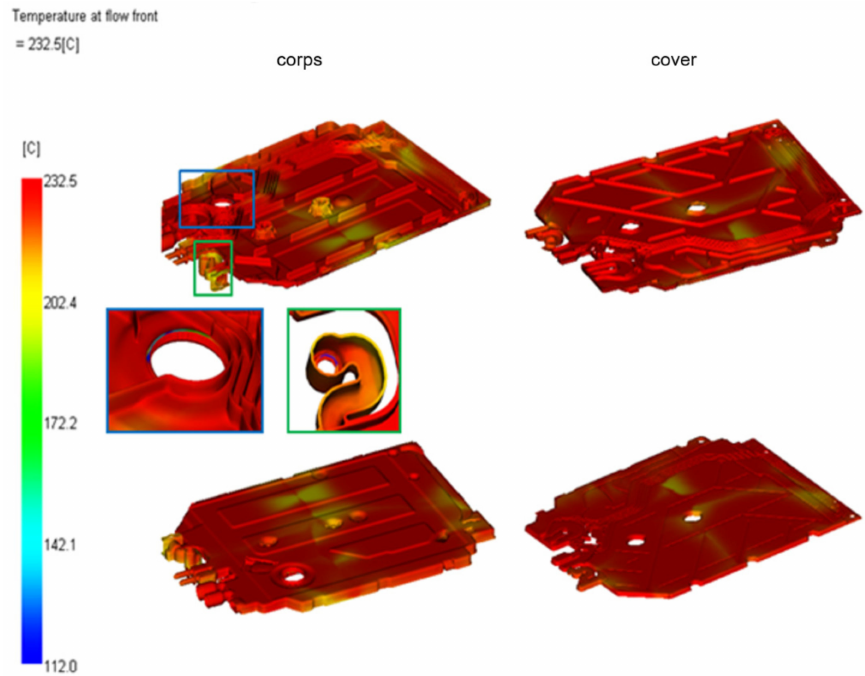
Figure 16. The temperature of the plastic flow front through the socket. Another analysis performed using Moldflow shows the so-called weld lines—areas (lines) of joining the plastic stream that forms at the meeting angle ( θ ) from 135 degrees or less. Such a line is very disadvantageous for moldings, not only because of the visual characteristics of the molded part but also because of the weakening of the bonding joint. Figure 17 shows the areas where the streams meet. The color of the welding lines indicates the temperature at which they are formed. Colder temperatures may indicate areas of the difficult seam, which in turn will affect the appearance of the weld line. The strength of the colder seam lines may also be lower than at locations with higher seam line temperatures. The length of the entire weld connecting the lines should be kept to a minimum. Where possible, the injection path should be designed to prevent such areas from forming (Figure 17).